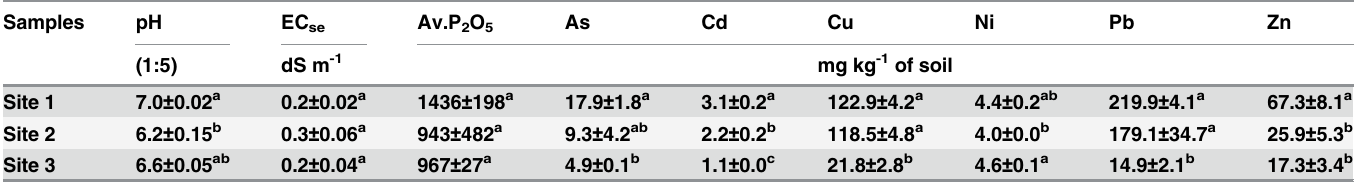
Values presented here are the mean of four replicas ± SE (standard error). Same letters in the column are not signi fi cantly different between sites at P <